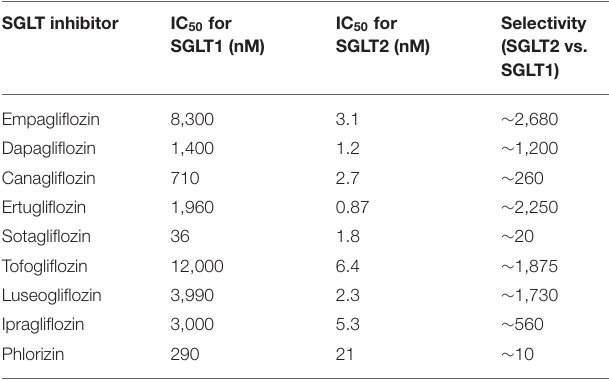
TABLE 1 | Differences between SGLT inhibitors in selectivity for SGLT2 vs. SGLT1. SGLT inhibitor